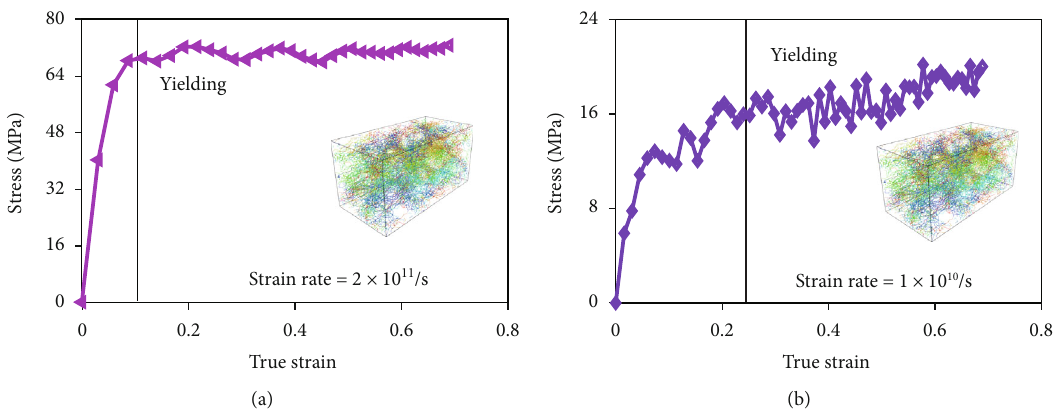
Figure 5: Stress-strain curves of the coarse-grained PU matrix containing 100 chains under tensile tension at the strain rate of (a) 2 × 10 11 /s and (b) 1 × 10 10 /s.